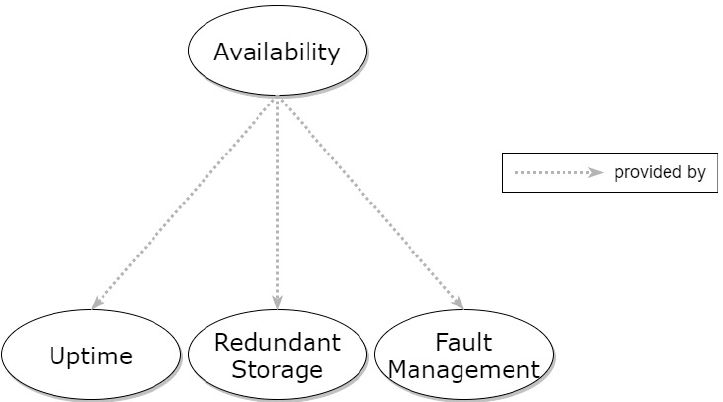
Figure 8. Hierarchical graph of Availability property and relevant patterns.